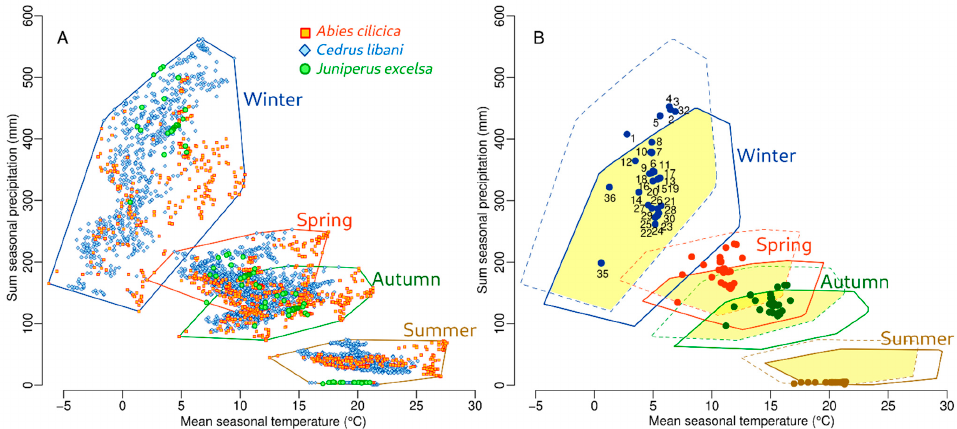
Figure 3. ( A ) Climate range of Abies cilicica (green dots), Cedrus libani (blue dots), and Juniperus excelsa (red dots) based on mean seasonal temperature and sum of seasonal precipitation. ( B ) The shifted climatic range overlaps with current values (yellow area) for a 2 °C increase in mean seasonal temperature and a 20% loss in seasonal precipitation sum. Populations studied (1 to 36, see Table 1) are plotted for each season (blue = winter, red = spring, green = fall, and maroon = summer).